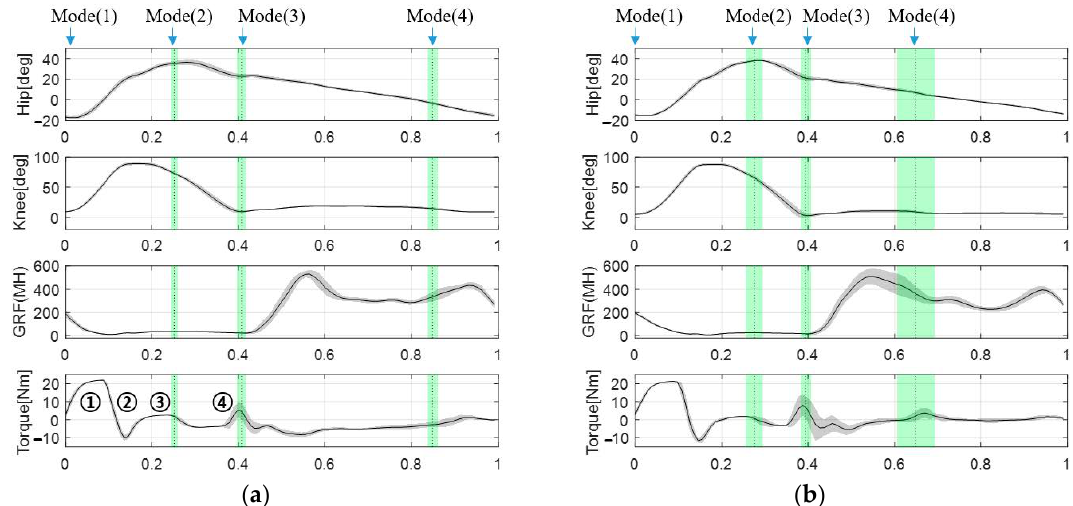
Figure 11. Normalized GRF, control torque output, and joint motion variation during a gait cycle. Vertical dotted lines and the shaded area represent the mean and standard deviation of the gait mode transition timing. Numbers ➀➁➂➃ represent flexion torque, damping torque for knee flexion, extension torque, and the damping torque for knee extension, respectively. ( a ) the left side gait cycle, and ( b ) the right side gait cycle.